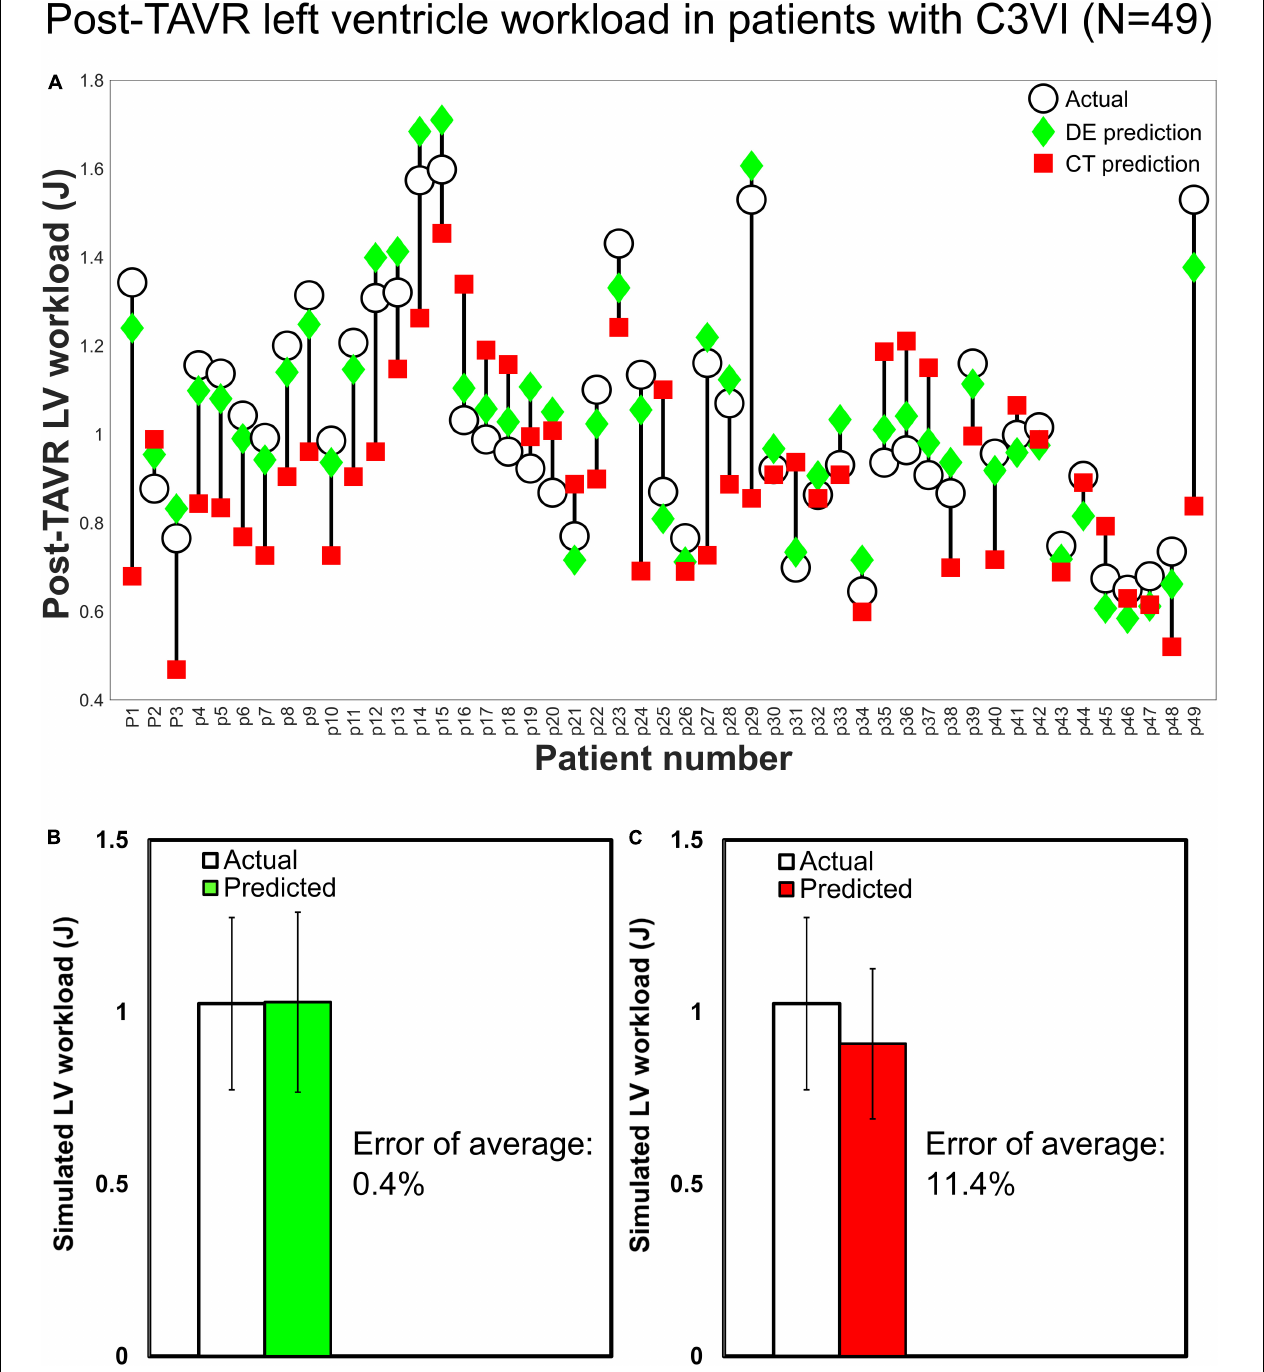
FIGURE 7 | Changes in predicted LV workload after intervention and actual post-intervention LV workload in patients with C3VI ( N = 49). (A) Computed by C3VI-DE and C3VI-CT. (B) Computed by C3VI-DE. (C) Computed by C3VI-CT. The two-sample t -test rejects the null hypothesis that the prediction and the actual values of the post-intervention LV workload have equal means for C3VI-CT predictions but not for C3VI-DE predictions at 0.01 significance.